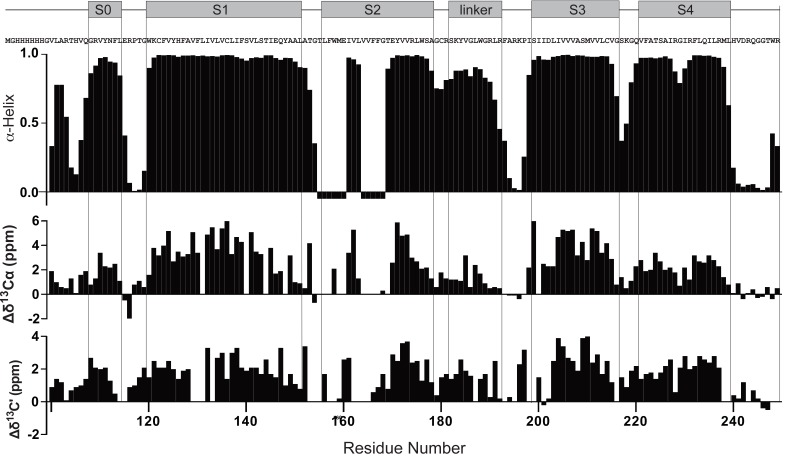
TALOS-N secondary structure analysis of backbone chemical shifts (top panel) and (bottom panels) deviations of the (Osteen et al., 2012) Cα and carbonyl 13C’ chemical shifts from random coil values.The chemical shift data for the KCNQ1 VSD been deposited in BioMagResBank (BMRB ID 30517).Figure 1—figure supplement 2—source data 1.Excel file with numerical data used for Figure 1—figure supplement 2.